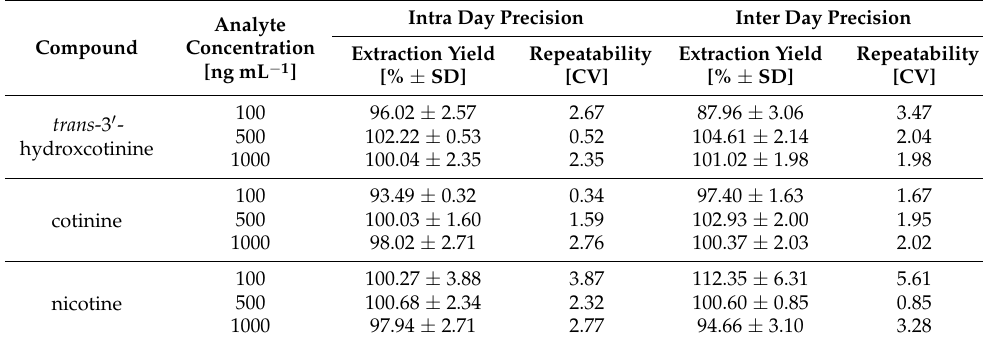
Table 2. The recoveries of trans -3 ′ -hydroxycotinine, cotinine, nicotine from the artificial plasma samples with intra- and inter-day precision.